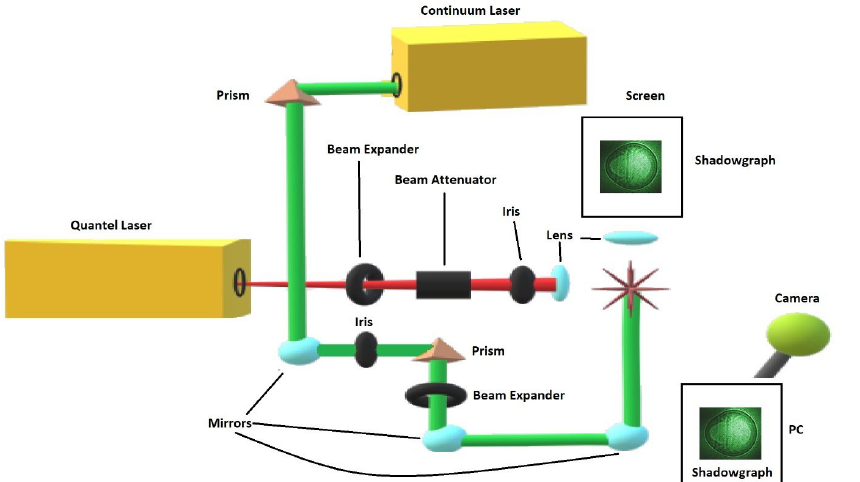
Figure 2. Module for recording shadow graphs of optical breakdown in air. The attenuated Quantel laser beam is focused with f/20 optics. The asterisk symbolically indicates optical breakdown. The interaction area is illuminated by time-delayed Continuum Surelite laser beams, and shadows are projected onto a screen and recorded with a digital camera